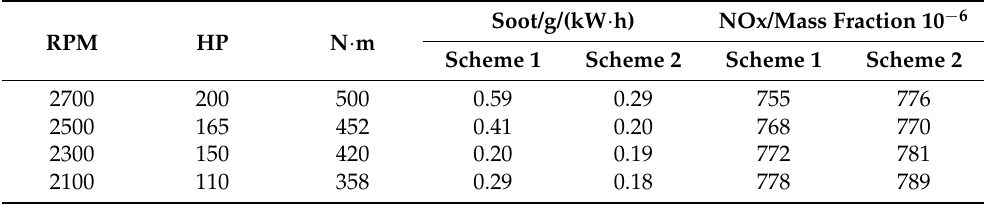
Figure 13. The piston of scheme 2. Table 4. Emission data under different operating conditions.